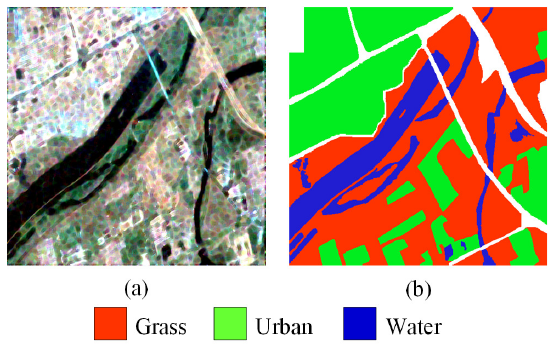
Figure 5. Xi’an image. ( a ) Pseudo-RGB image. ( b ) Ground truth.